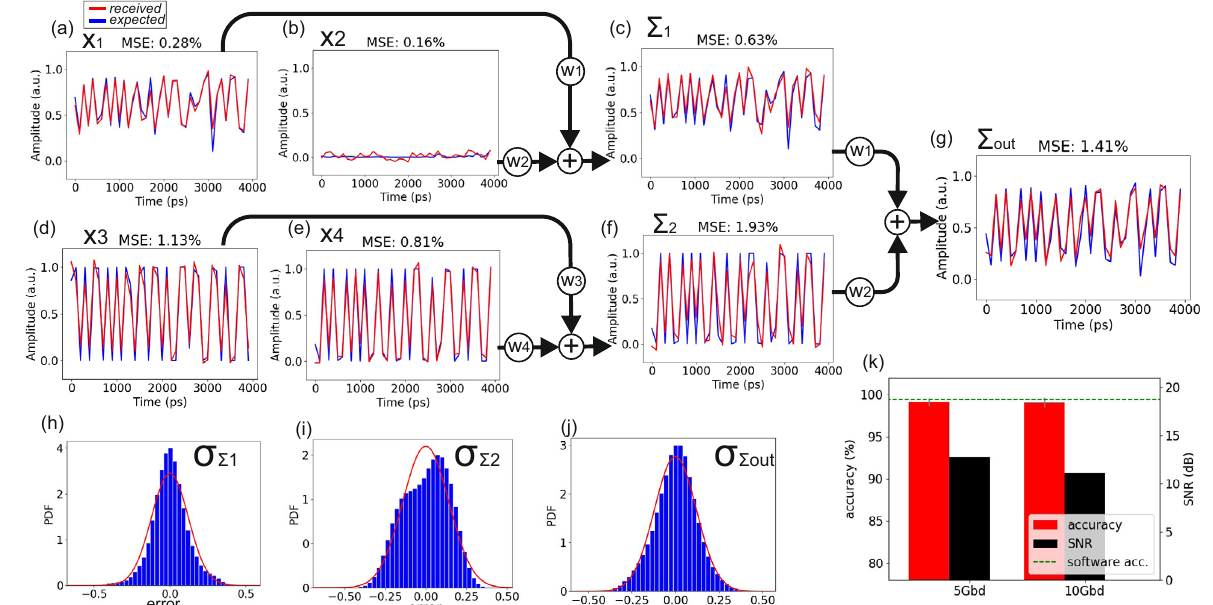
each dot product Σ i and the respective fi tting with the Gaussian distribution and k accuracy and SNR measurements at 5 and 10GMAC/sec/axon.